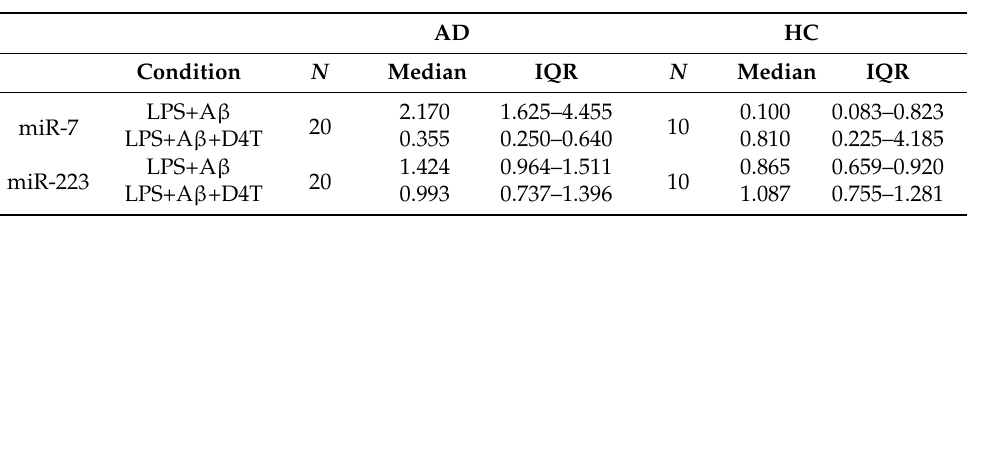
Table 2. Summary results of miRNA expression in PBMC of AD patients and